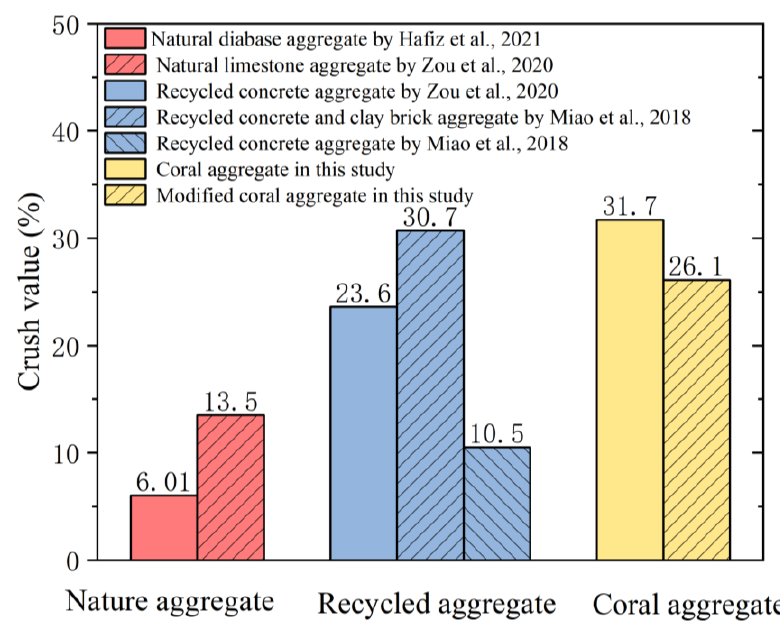
Figure 9. Comparison of C r of different types of aggregates [56–58].